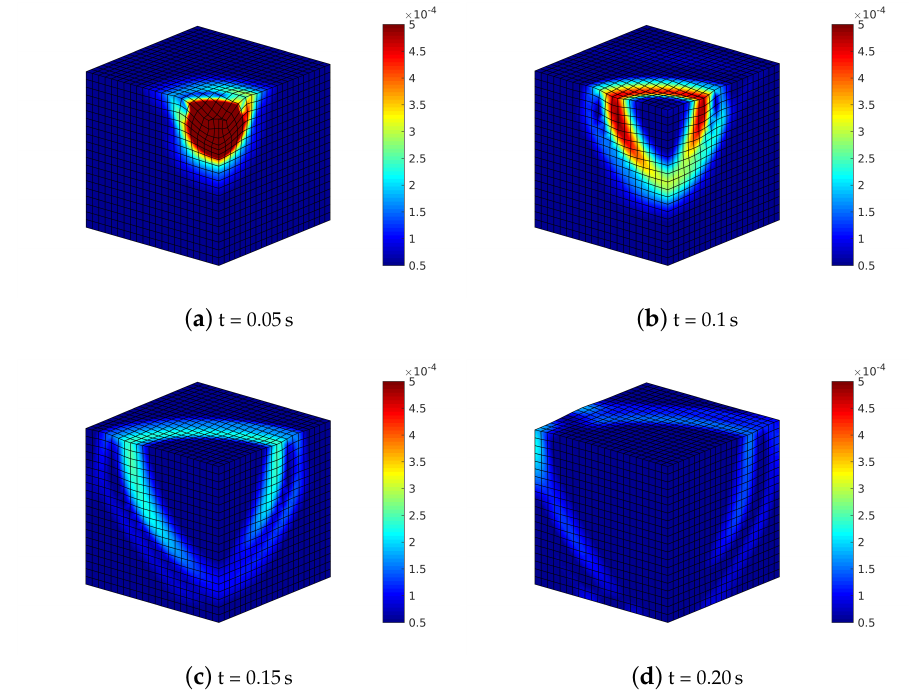
Figure 14. Transversely isotropic soil model with α = 90 ◦ : deformed meshes (amplified by scale factor 500) and contours of norm of soil displacements vector